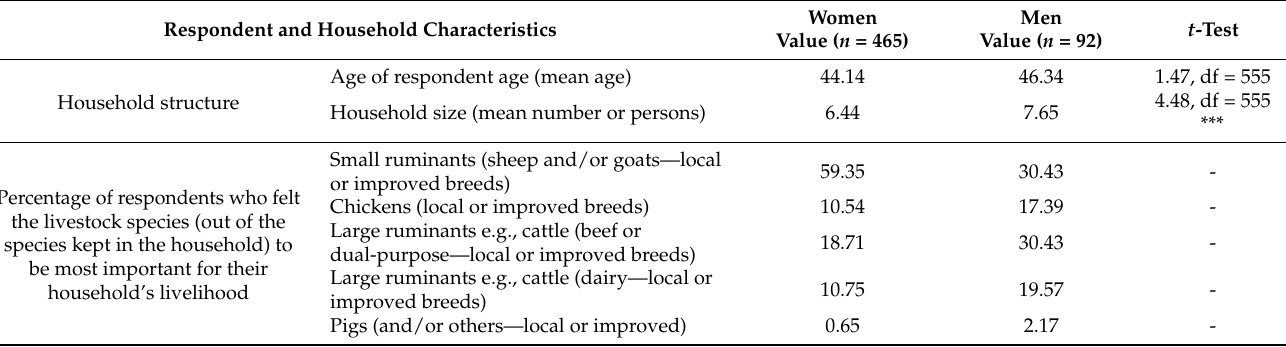
Table 2. Sociodemographic characteristics of respondents and their